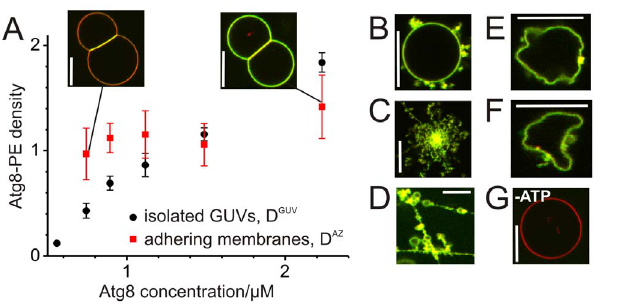
Fig. 2. Atg8-PE density on GUVs depends on Atg8 concentration. ( A ) Atg8-PE densities on isolated GUVs (D GUV ) and in adhesion zones between two GUVs (D AZ ) as a function of the bulk Atg8 concentration; insets show adhering GUVs for the indicated concentrations; mean ¡ SEM, n 5 9–12 GUVs per concentration. At the highest Atg8-PE density examined, GUVs spontaneously form external protrusions ( B ), while some GUVs disintegrate into tubular networks ( C, D ) or show pronounced non-fluctuating deformations ( E, F ). This behavior is not observed in the absence of ATP ( G ). All snapshots are merged dual color images; scale bars 10 m